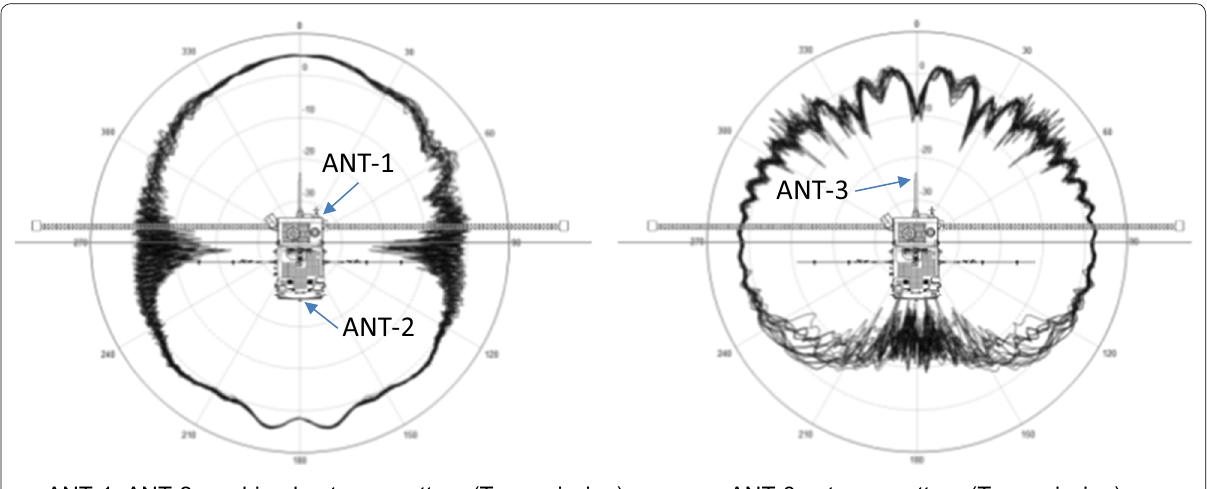
ANT-3 antenna pattern (Transmission)ANT-1, ANT-2 combined antenna pattern (Transmission)